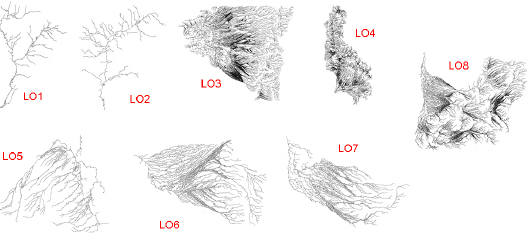
Figure A1. Drainage networks extracted from Loa basin.